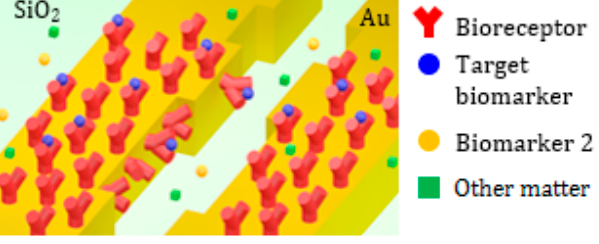
Figure 12. Schematic of the surface biosensing in the plasmonic cavity for selective detection of a target biomarker.